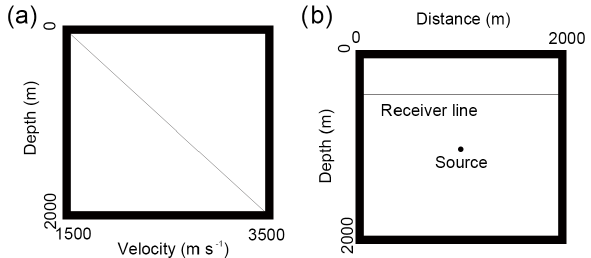
Figure 14. (a) Velocity profiles in depth; (b) distribution of source and